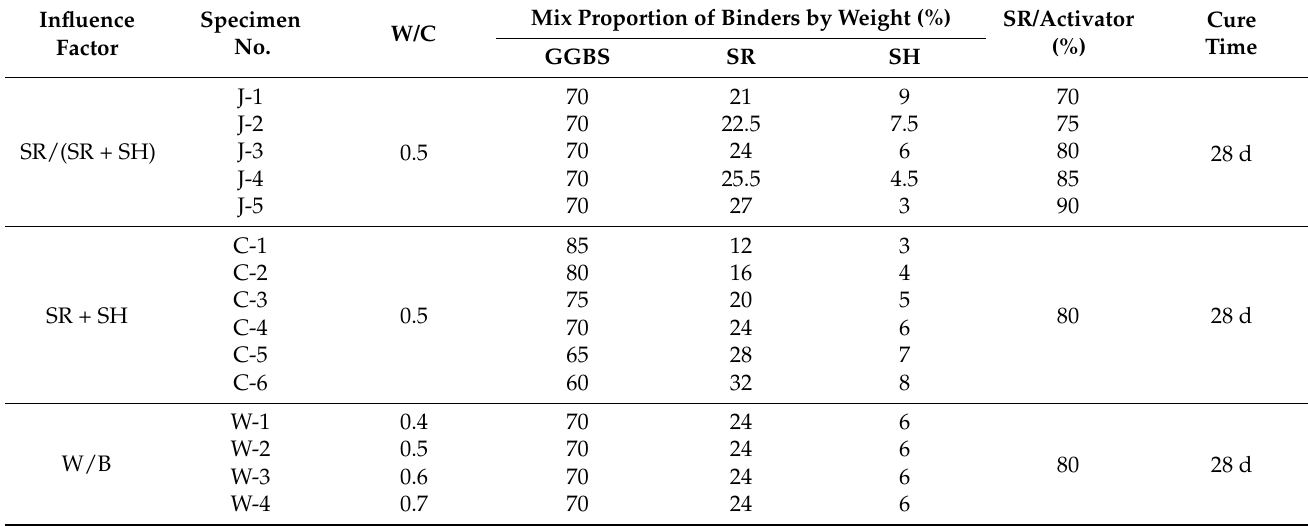
Table 2. The mix proportion.